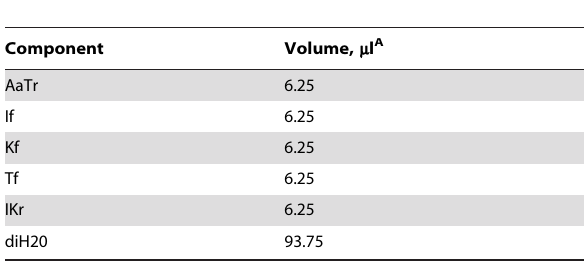
Table 10. Preparation of 125 m l primer stock for V. isaacii–V. klebahnii–V. tricorpus multiplex PCR assay sufficient for 50 25- m l PCR